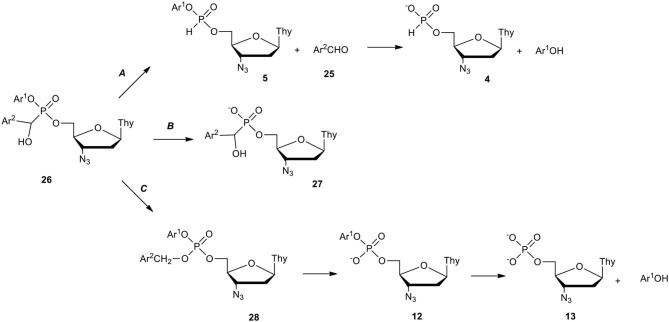
Decomposition paths of aryl nucleoside α-aryl-α-hydroxyphosphonates of type 26 in RPMI/FCS on the example of AZT derivatives.